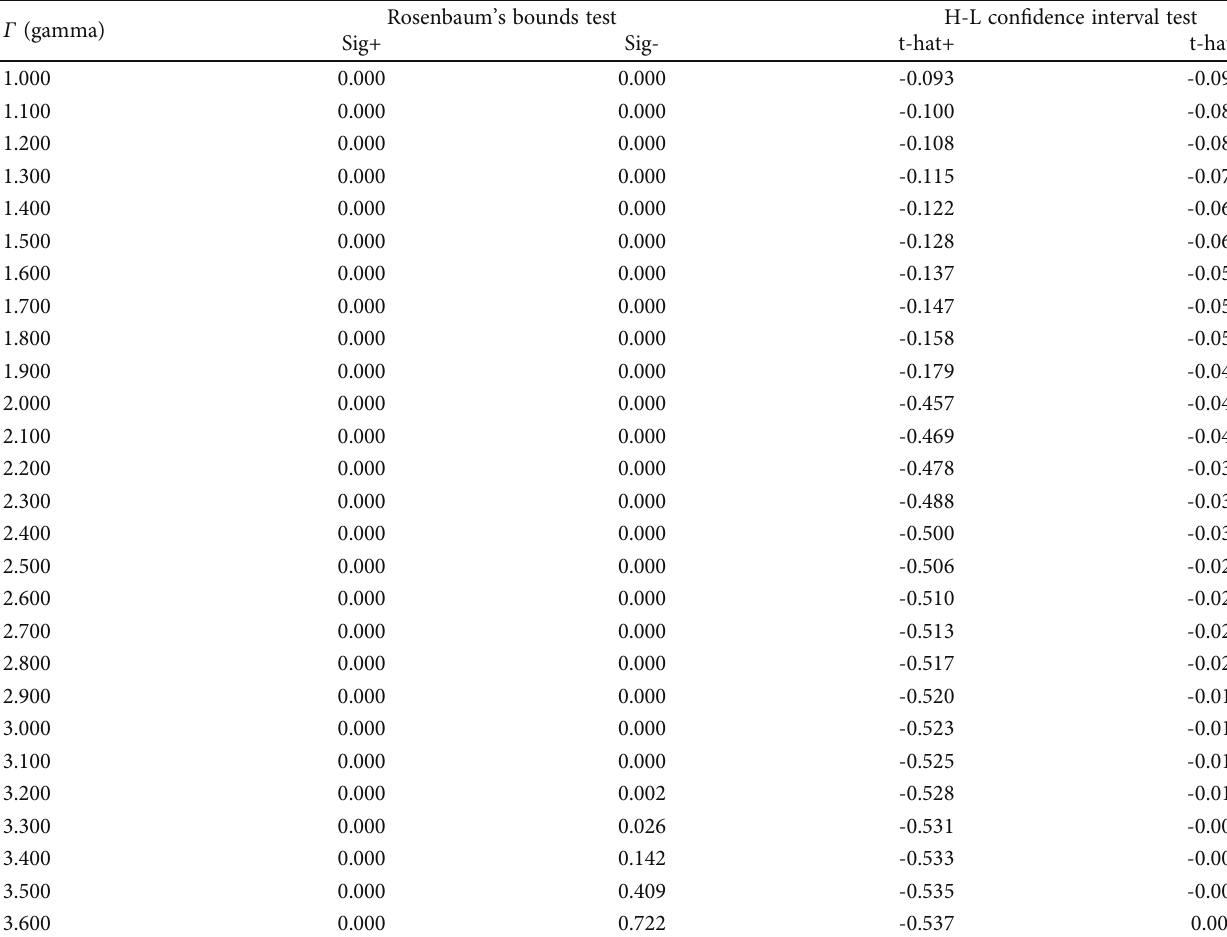
Table 5: Sensitivity test